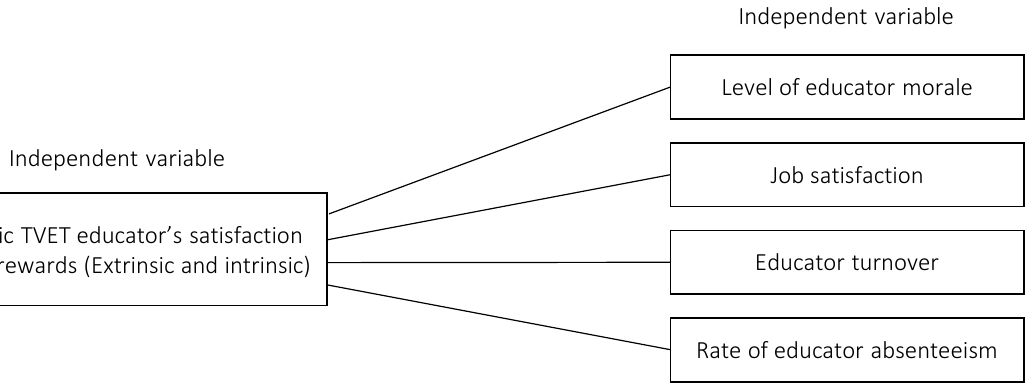
Figure 1. Schematic diagram of the theoretical framework